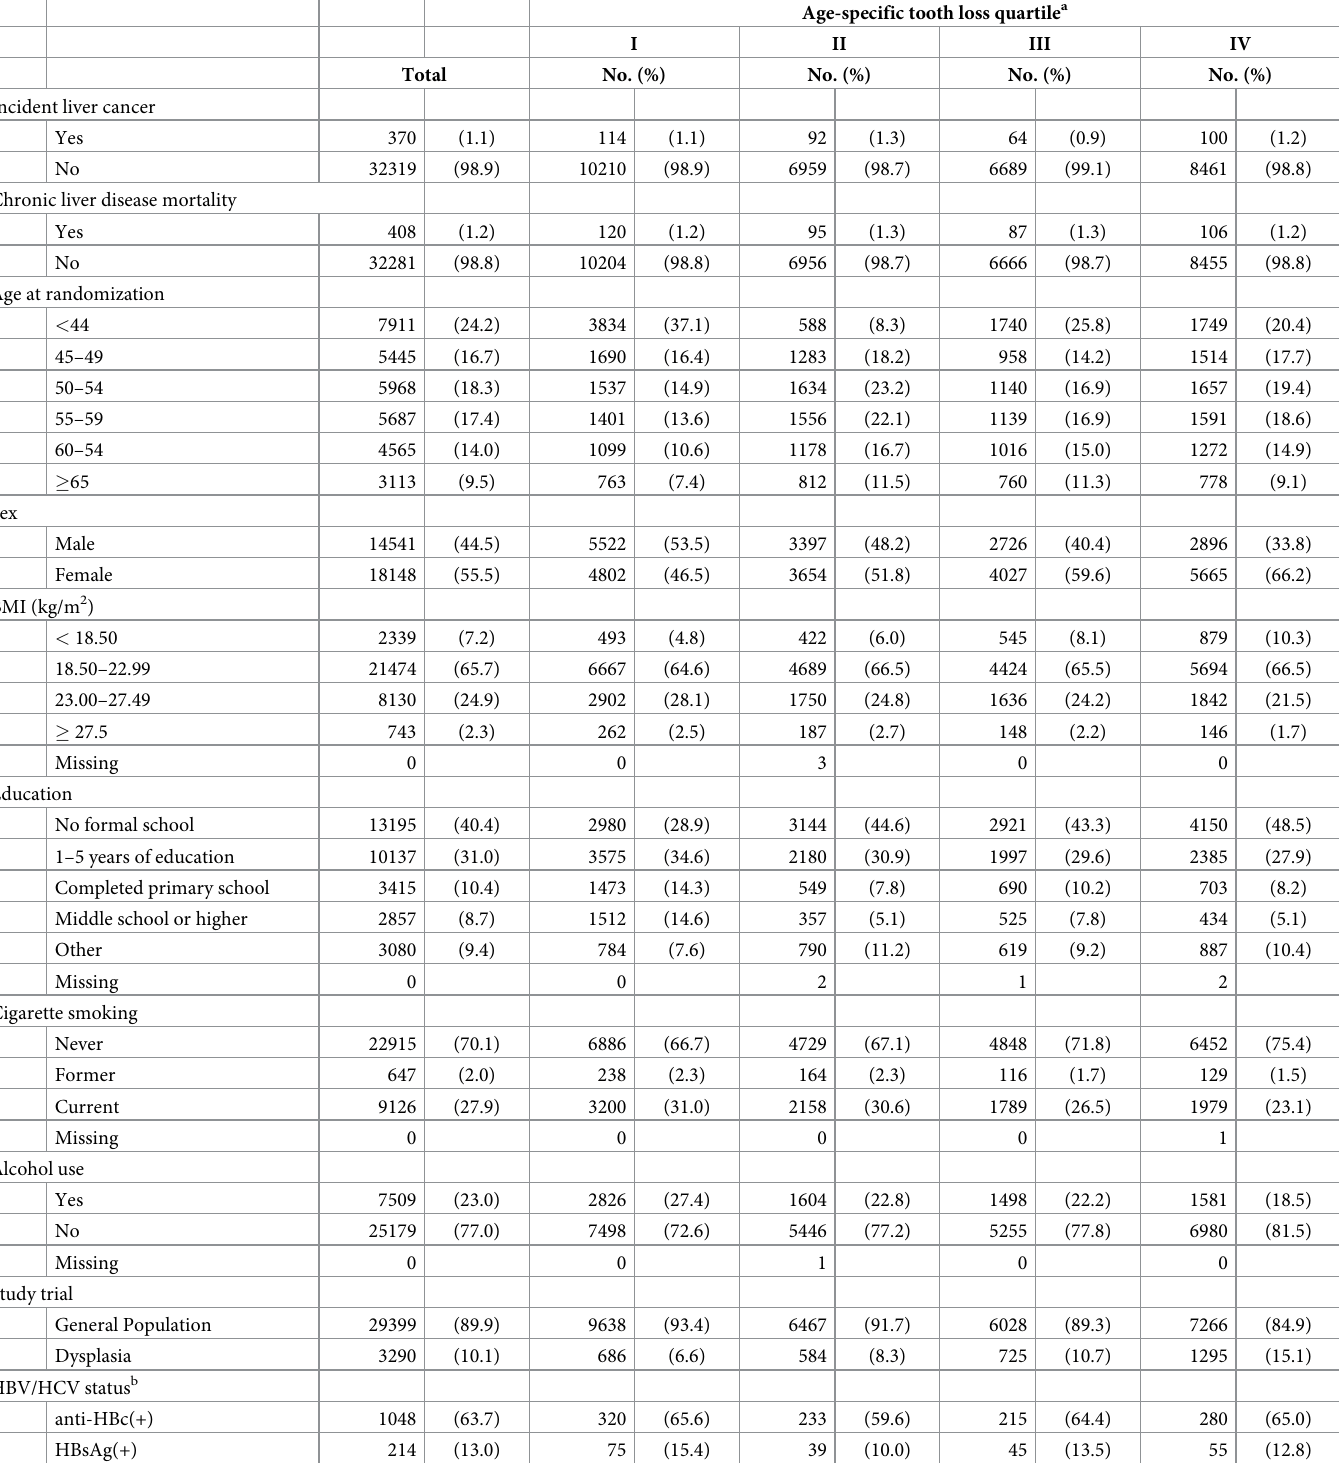
Table 1. Characteristics of study participants by age-specific tooth loss quartile in the Nutrition Intervention Trials Cohort, Linxian, PRC,